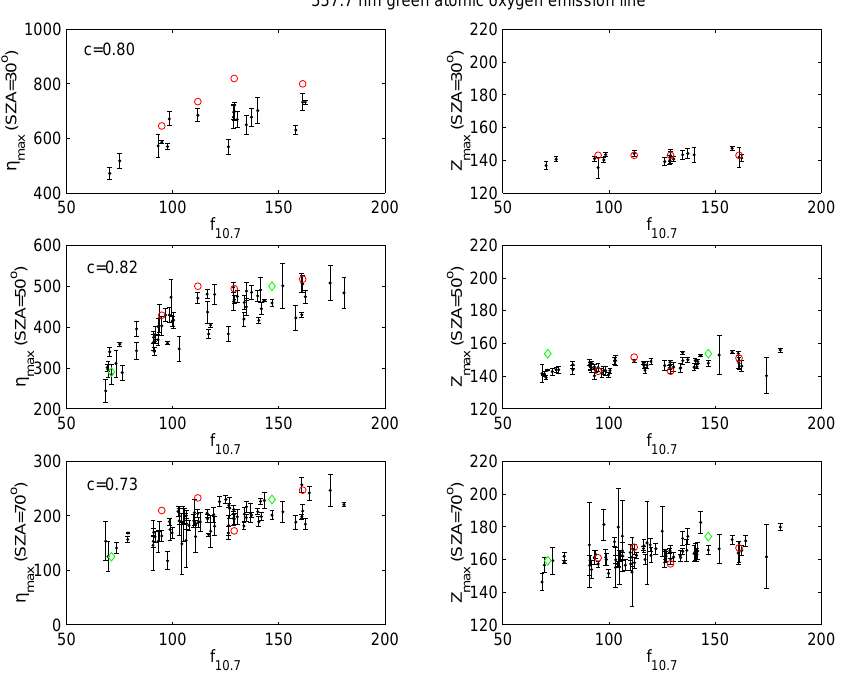
Fig. 13. WINDII measurements of the 557.7nm (thermospheric peak) volume emission rates and maximum emission altitudes for quiet geomagnetic days ( A p ≤ 10), from 1992 to 1995. Data are plotted versus the f 10 . 7 index, and error bars correspond to the standard deviation. Diamonds correspond to the TRANSCAR simulation results presented in Sect. 4.1.2, and circles are simulations results for intermediate solar activity.